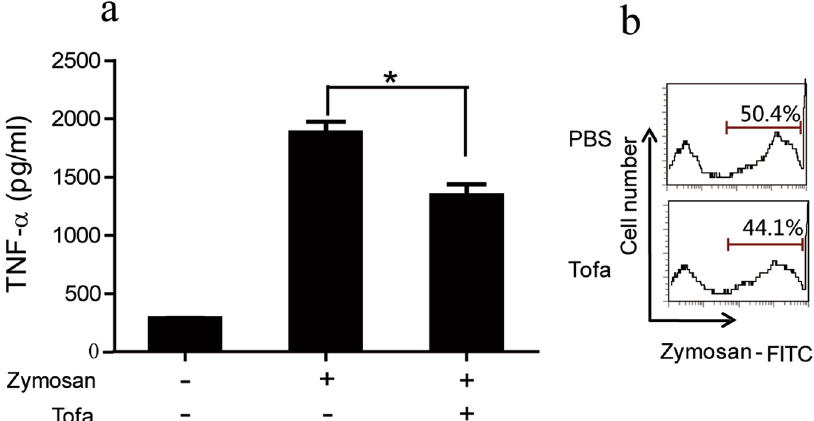
Figure 5. Effects of Tofacitinib on C. albicans –induced PBMC and monocyte responses. ( a ) Freshly prepared human PBMCs were stimulated with zymosan in the presence, or absence, of tofacitinib (1 μ M) for 24 h, and then TNF α in the supernatant quantitated by ELISA. * p < 0.05. ( b ) CD14 + monocytes, fractionated from human PBMC, were treated with tofacitinib or PBS for 2 h and then with FITC-labeled zymosan for 1 h, followed by FACS analysis. Representative histograms are shown in the left panels with zymosan-containing positive peaks indicated by red bars. Repeating results using samples from 3 unrelated donors were converted into phagocytosis (fluorescence positive cells) for statistical comparison between groups treated with PBS (filled circle) or tofacitinib (open circle). ** p <